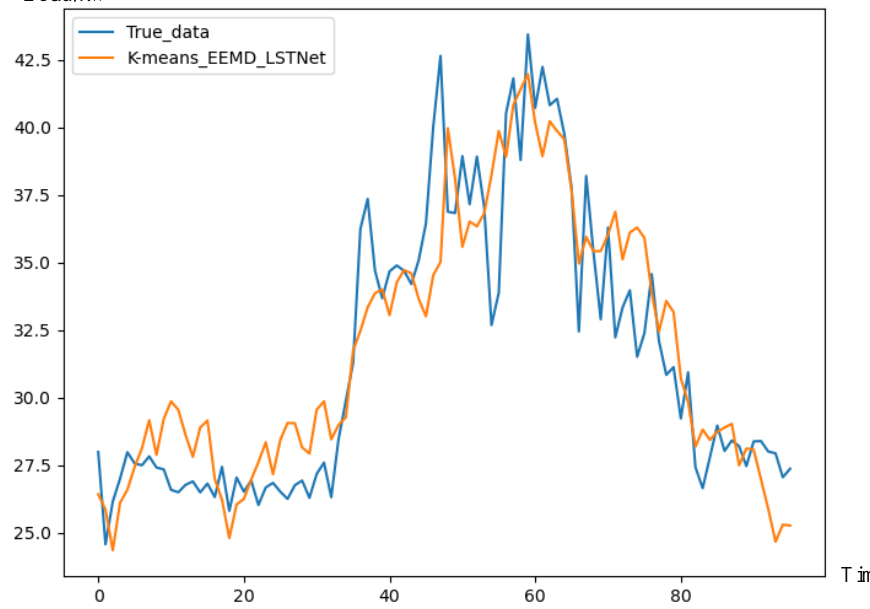
Figure 7. Comparison between the load forecasting results and the actual load on 18 March 2022.